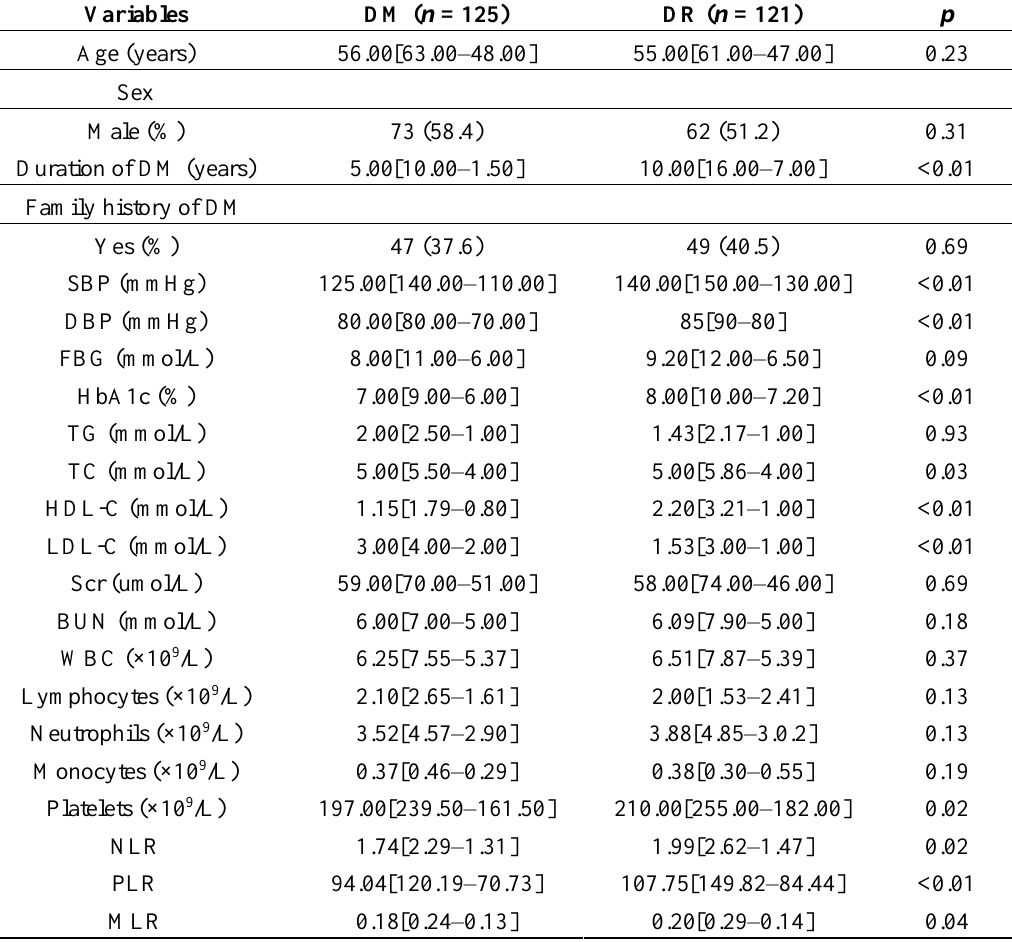
Table 1. Patients’ baseline and clinical